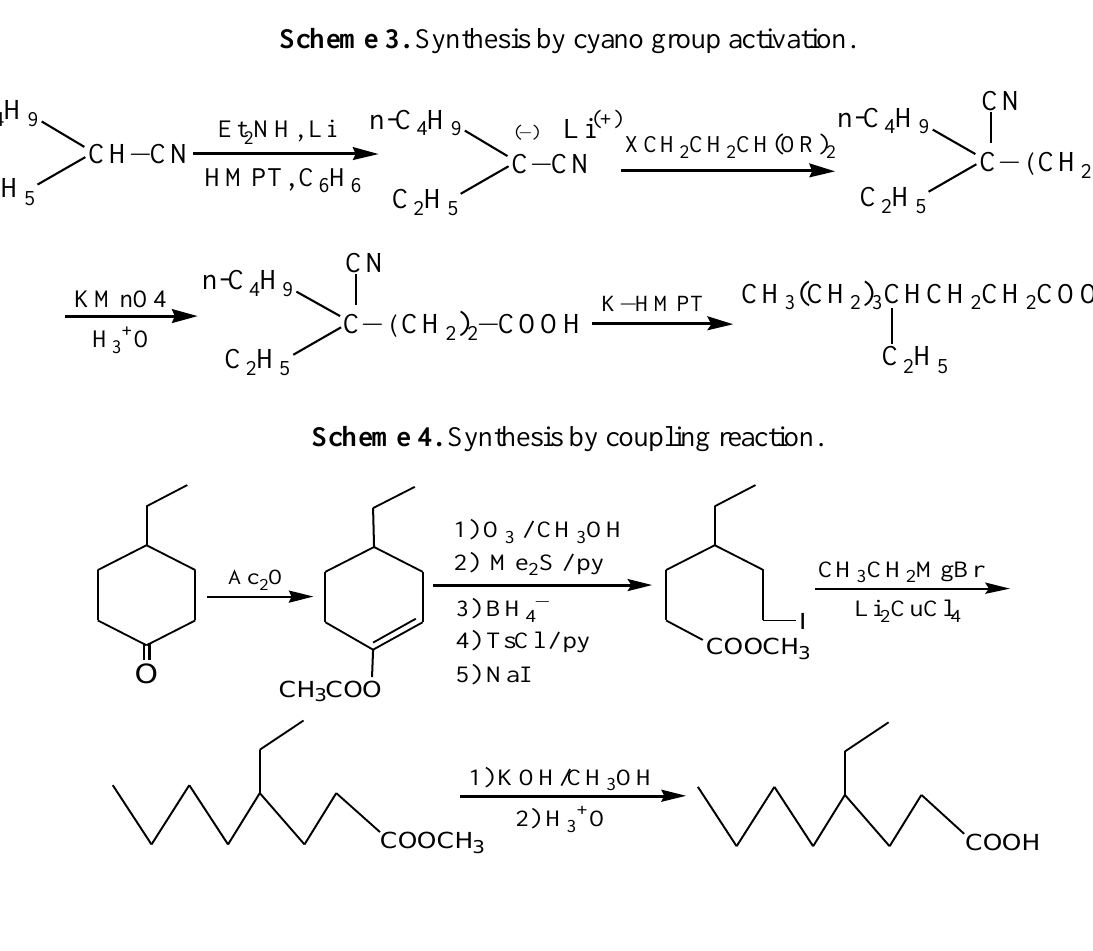
Scheme 3. Synthesis by cyano group